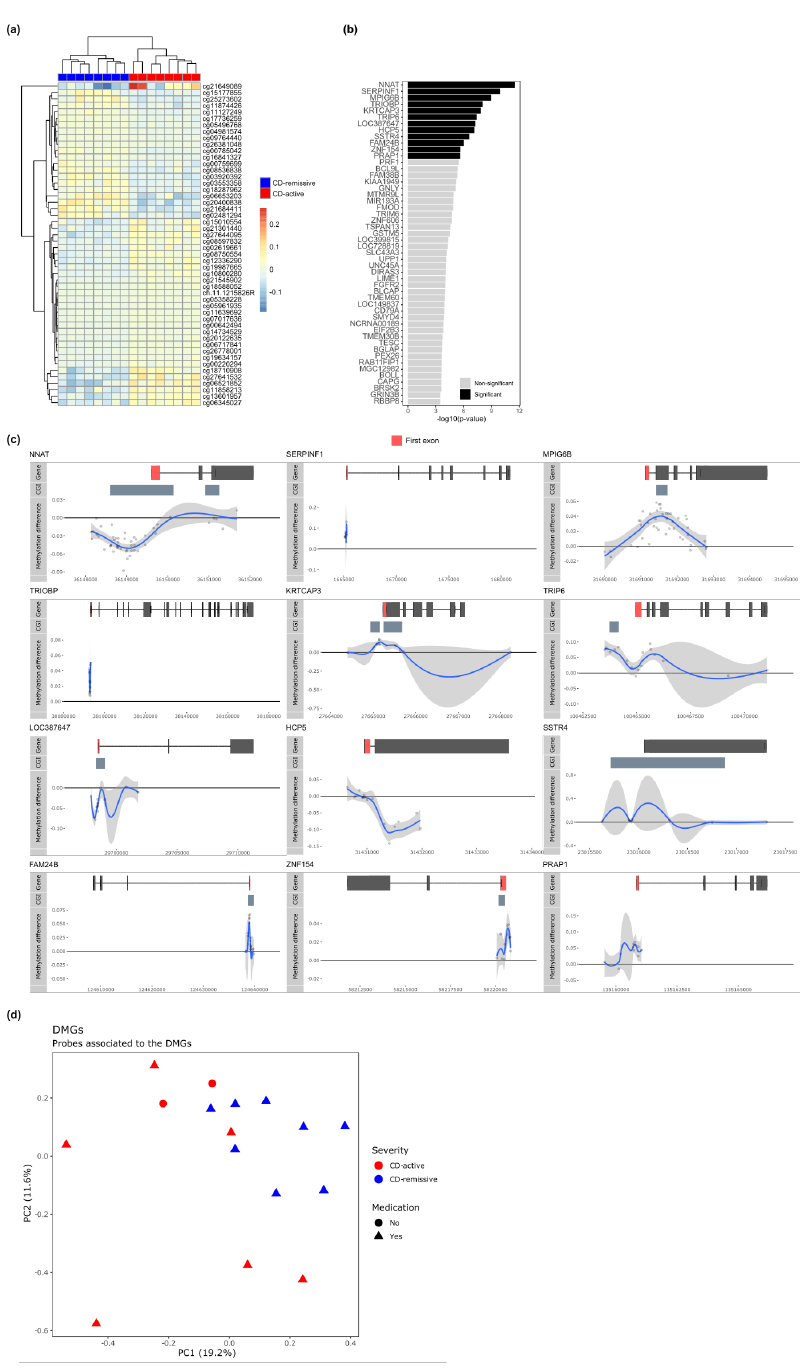
Figure 2. Comparing CD-active (n = 8) with CD-remissive (n = 8). ( a ) Heatmap organized by hierarchical clustering of the 50 most DMPs annotated with Illumina probe IDs. ( b ) Barplot depicting the − log 10 ( p -value) obtained from Brown’s method for the DMGs. Significant DMGs are indicated in black, while non-significant genes are indicated in grey. ( c ) Visualization of the significant DMGs by plotting the di ff erence in percentage methylation relative to the position on the chromosome and the gene (“Gene”) and CpG island (“CGI”) features as obtained from UCSC. Dots represent probes on the Illumina HumanMethylation 450k BeadChip array. The blue trend line represents the loess-smoothed average across all methylation probes for the indicated region with surrounding grey area representing the standard error. ( d ) Principal component analysis performed on the probes associated to the DMGs for the CD patients